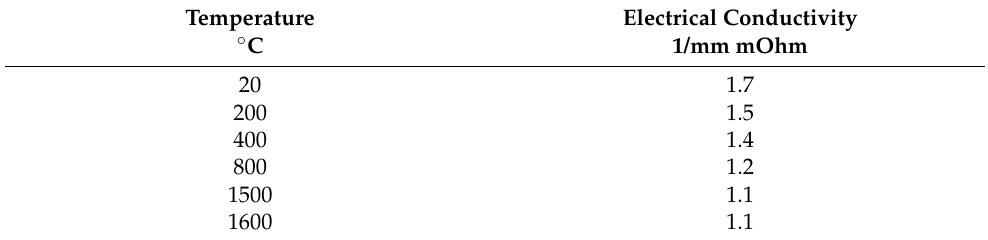
Table 5. Temperature dependent electrical material conductivity σ e